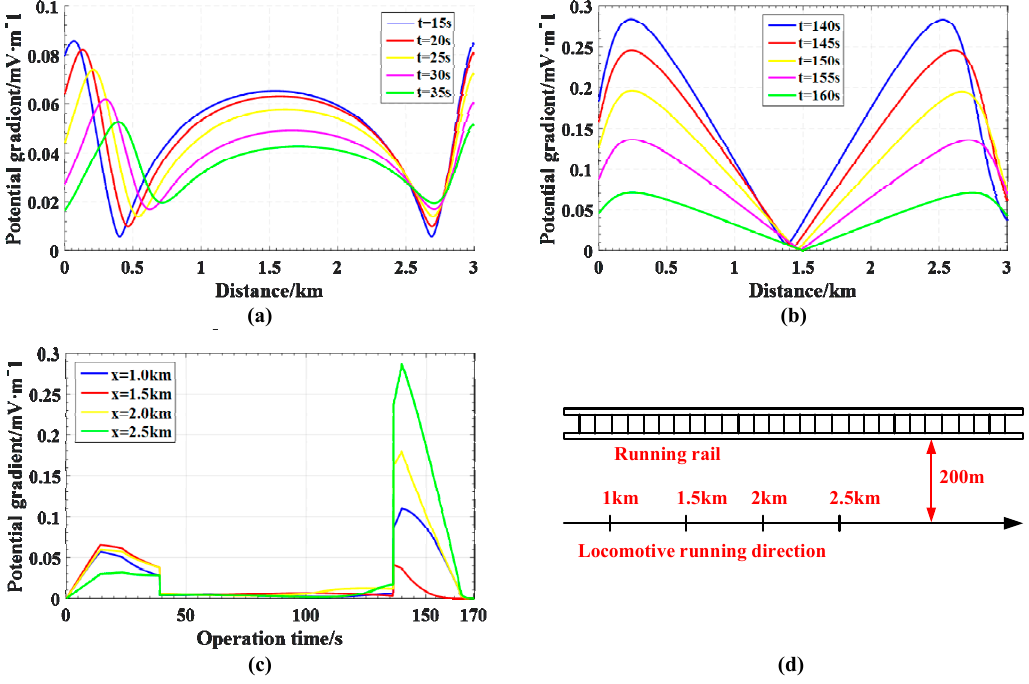
Figure 11. Dynamic surface potential gradient: ( a ) Acceleration mode; ( b ) Deceleration mode; ( c ) Surface potential gradient during the entire locomotive operation; ( d ) Position instructions.